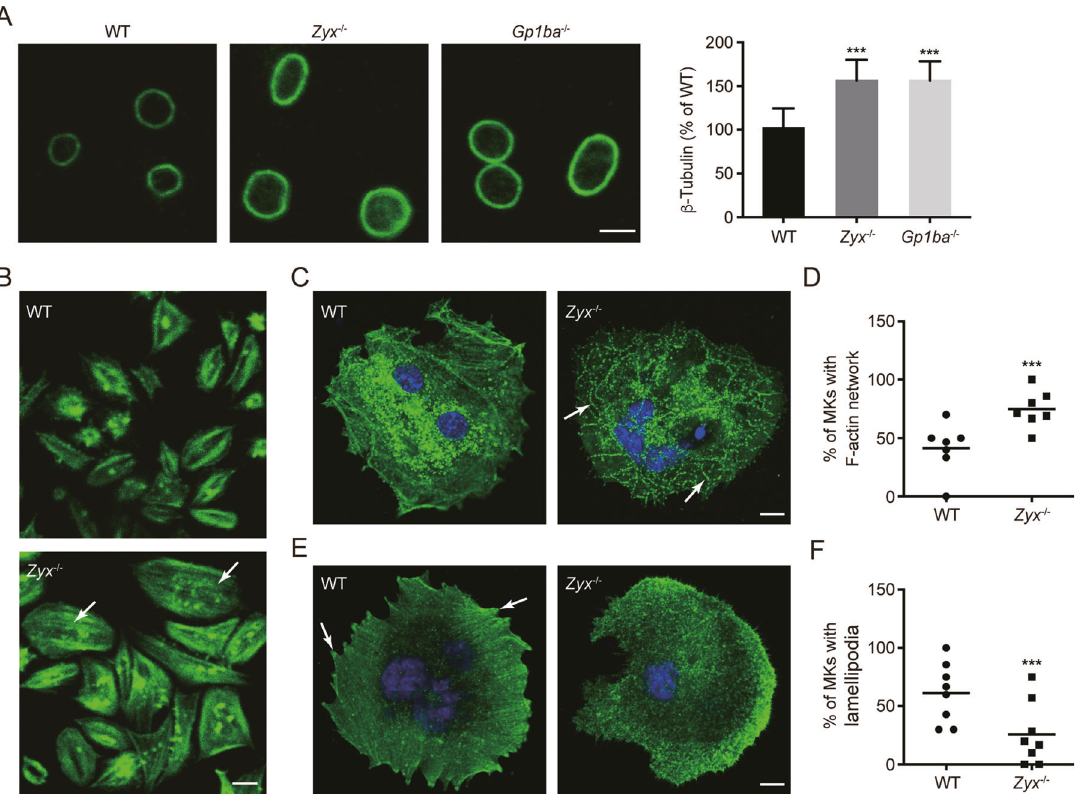
Fig. 5 Zyxin de fi ciency affects microtubule and actin cytoskeleton organization. A Left panels, representative confocal images of resting WT, Zyx − / − and Gp1ba − / − platelets stained for β -tubulin (green). Scale bar: 3 μ m. Right panel, the quanti fi cation of MFI of β -tubulin on the left was analyzed by ImageJ software; n = 10 visual fi elds from fi ve mice per genotype. Data are expressed as means ± SD. B Confocal images of WT and Zyx − / − platelets were allowed to spread on fi brinogen in the presence of thrombin and stained for F-actin (green). Scale bar: 3 μ m. Images are representative of fi ve independent experiments. C, D MKs cultured from mouse FL HPCs were allowed to spread on type I collagen. Representative confocal images of spread WT and Zyx − / − MKs stained for F-actin (green) and nuclei (blue); scale bar: 10 μ m ( C ). The percentage of MKs with the organized F-actin network along collagen fi bers (as indicated by arrows in C ) ( D ). No less than 60 MKs per genotype from seven independent experiments were analyzed. E, F MKs cultured from mouse FL HPCs were allowed to spread on fi brinogen. Representative confocal images of spread WT and Zyx − / − MKs stained for F-actin (green) and nuclei (blue); scale bar: 10 μ m ( E ). The percentage of MKs with lamellipodia (as indicated by arrows in E ) ( F ). No less than 60 MKs per genotype from eight independent experiments were analyzed ( C – F ). The original magni fi cation of all the images is ×630. Means are indicated by horizontal lines in ( D ) and ( F ). *** P < 0.001, compared with WT mice by one-way ANOVA followed by Dunnett ’ s post hoc test in ( A ) and by unpaired Student ’ s t -test in ( D ) and ( F